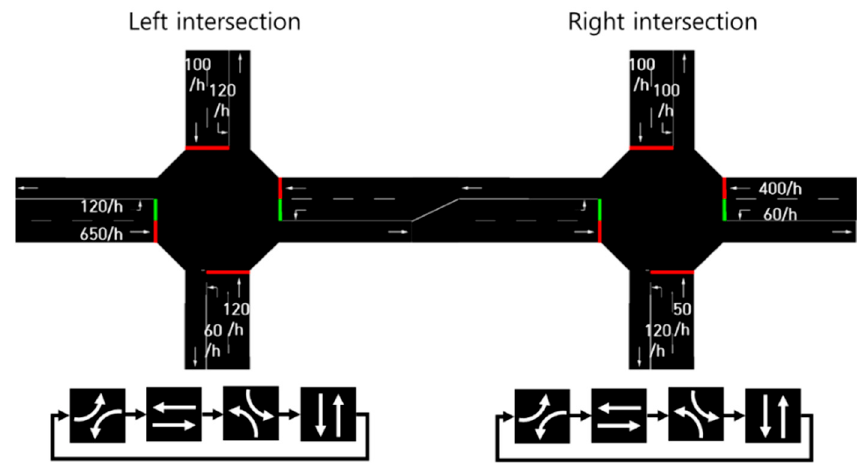
5 of 13 Table 1. Parameters used in the model. Parameters